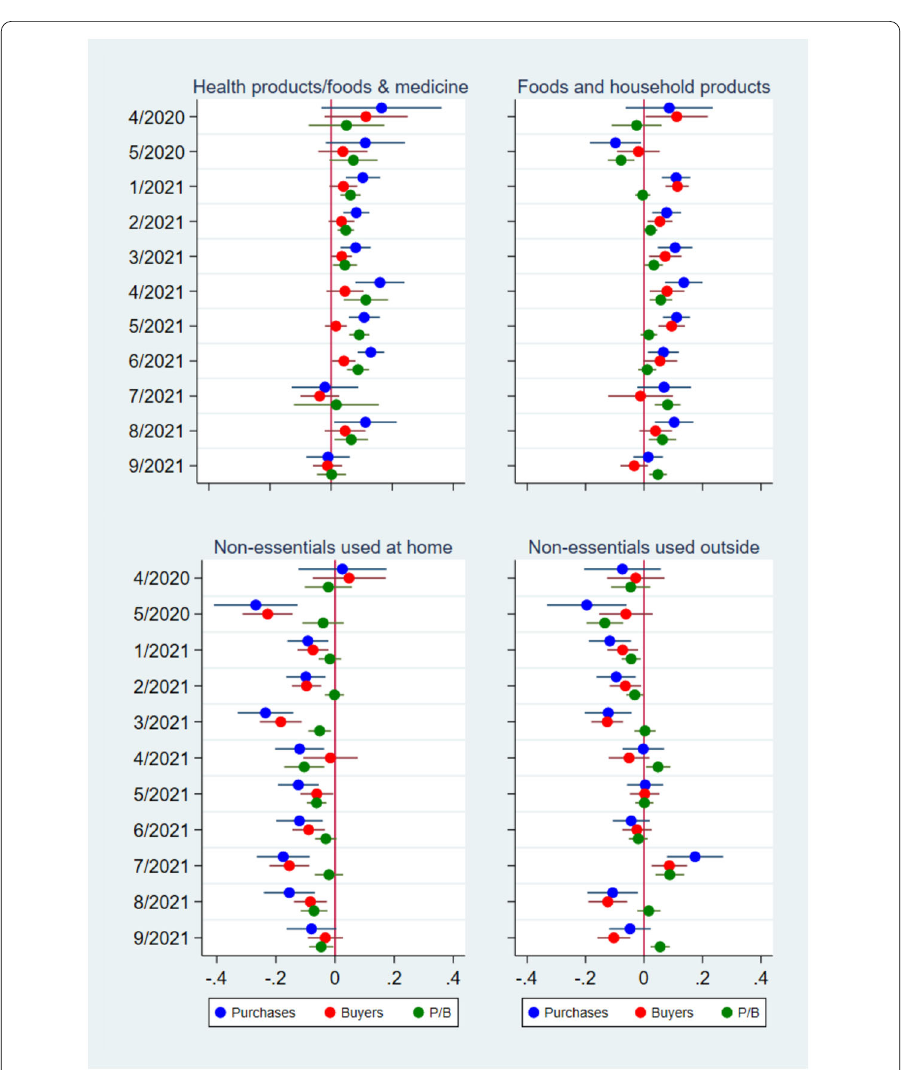
Figure 10 Effects of a State of Emergency on the Purchase Amount, the Number of Buyers, and the Purchase Amount per Buyer by Product Category. This figure illustrates the results from the regressions of the purchase amount, the number of buyers, and the purchase amount per buyer in logs at the prefecture–product–date level by the product category. The dots and lines indicate the coefficients and 95% confidence intervals of the effect of the dummies for 1-4 weeks after a state of emergency (SoE) in different months on the purchase amount (blue), the number of buyers (red), and the purchase amount per buyer (green). In all the regressions, the other independent variables are the dummies for an SoE; the dummies for before an SoE; the number of COVID-19 cases per 1000 persons; the number of neighboring prefectures in an SoE; and the prefecture, product, date, and day-of-the-week fixed effects. The standard errors are clustered at the prefecture and date levels. N = 188,437